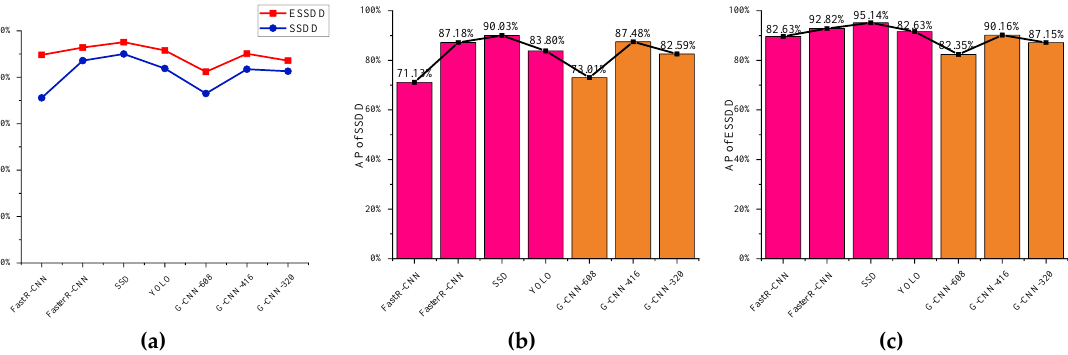
Figure 19. The impact of models built from the SSDD and ESSDD on AP by different methods. (a) AP of the SSDD and ESSDD; (b) AP of the SSDD; (c) AP of the ESSDD.